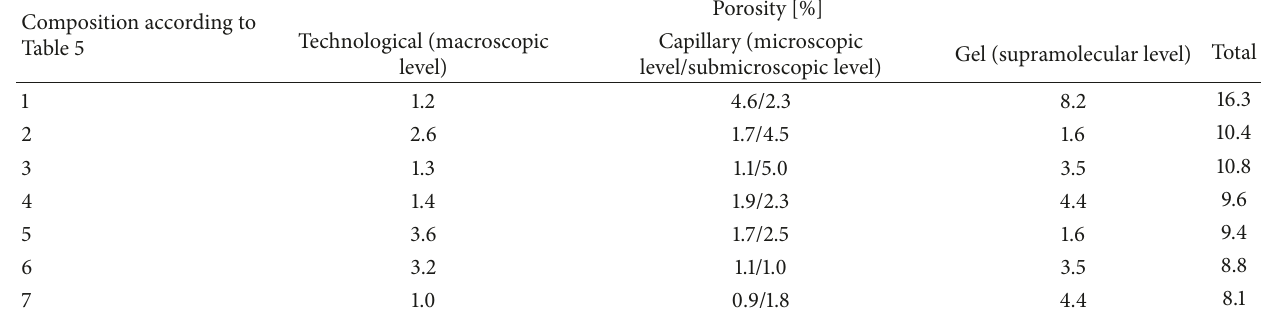
Table 7: Influence of the composition of the composite binder to the cement stone porosity.